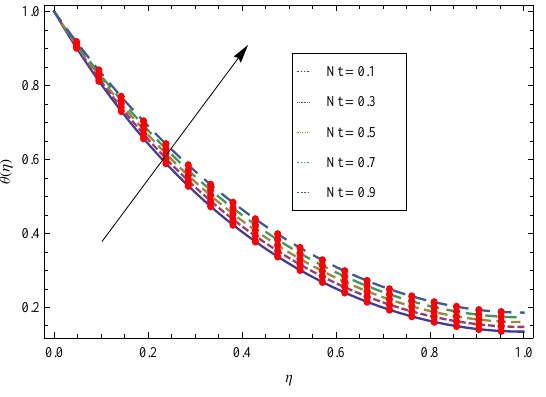
Figure 20. Indicates the effect of Nb on φ ( η ) , for h = − 0.9, λ = 0.5, S = 0.7,kr = 0.5,Pr = 0.5, Ec = 0.5,Nt = 0.7, β = 1 and Sc = 0.5.